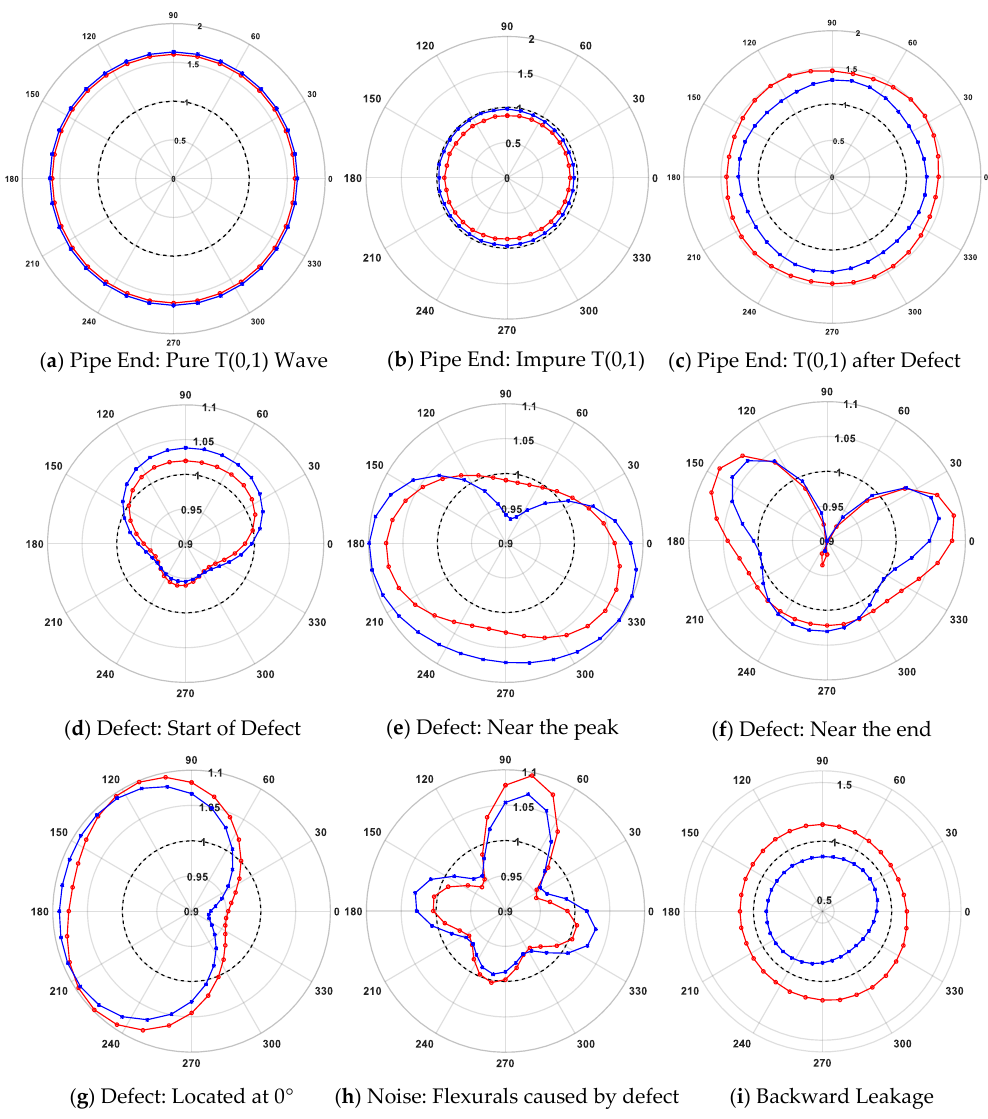
Figure 1. Spatial signal reception from two rings of 32 source points from various features where the red, blue, and black dotted lines are showing the first ring, second ring, and the reference offset.